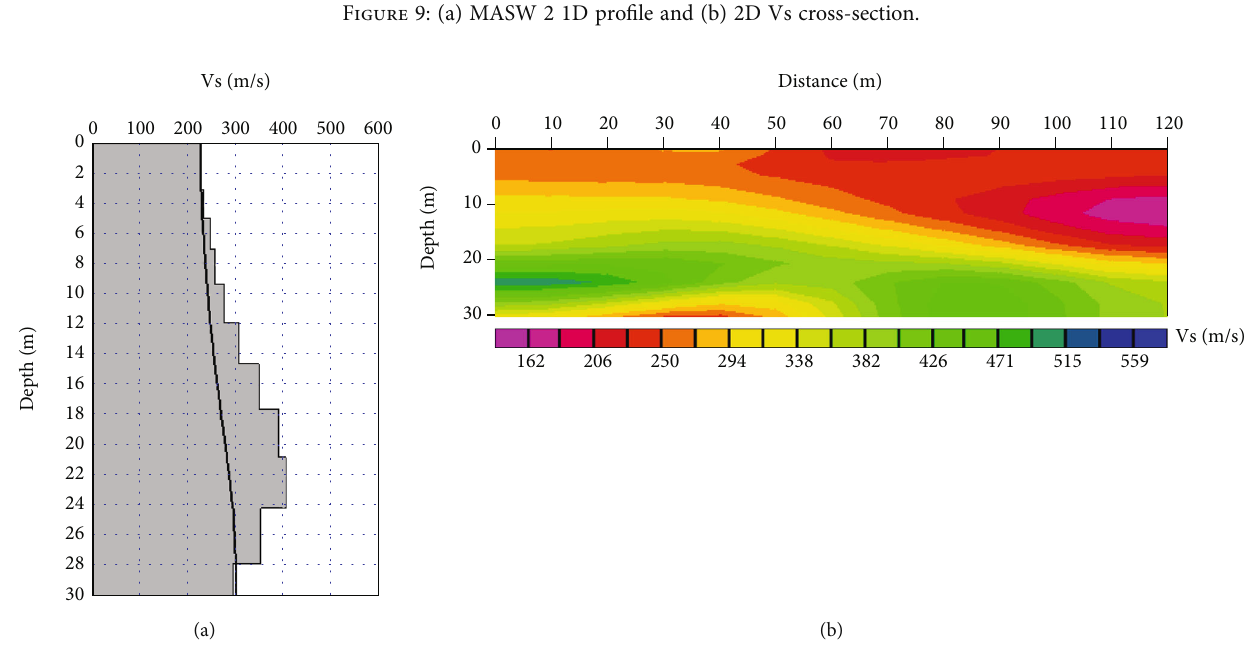
Figure 10: (a) MASW 3 1D Vs pro fi le and (b) MASW 2D vs cross-section.